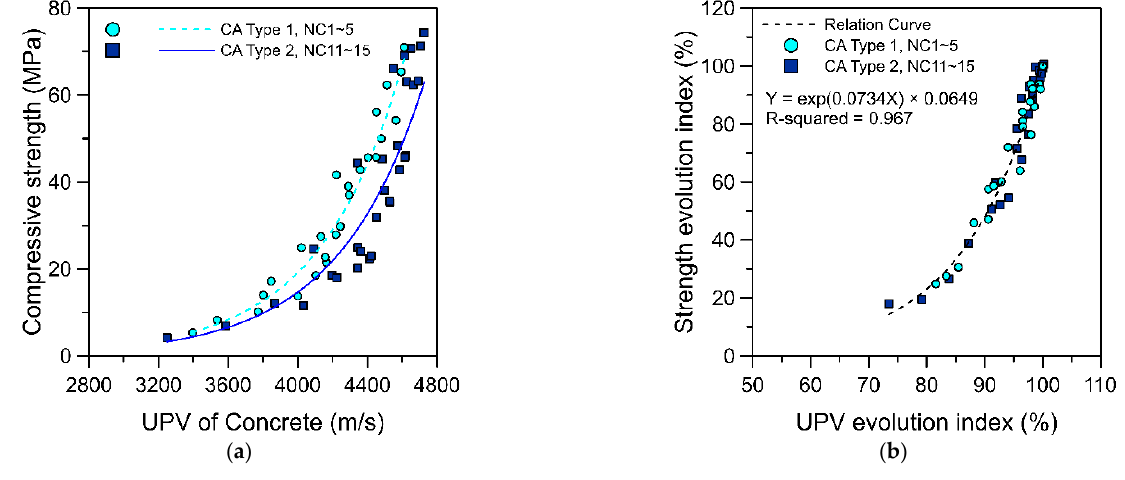
Figure 5. Relationship between UPV and strength for normal concrete specimens with different types of aggregate: ( a ) UPV and strength, ( b ) UPV and strength evolution index. of aggregate: ( a ) UPV and strength, ( b ) UPV and strength evolution